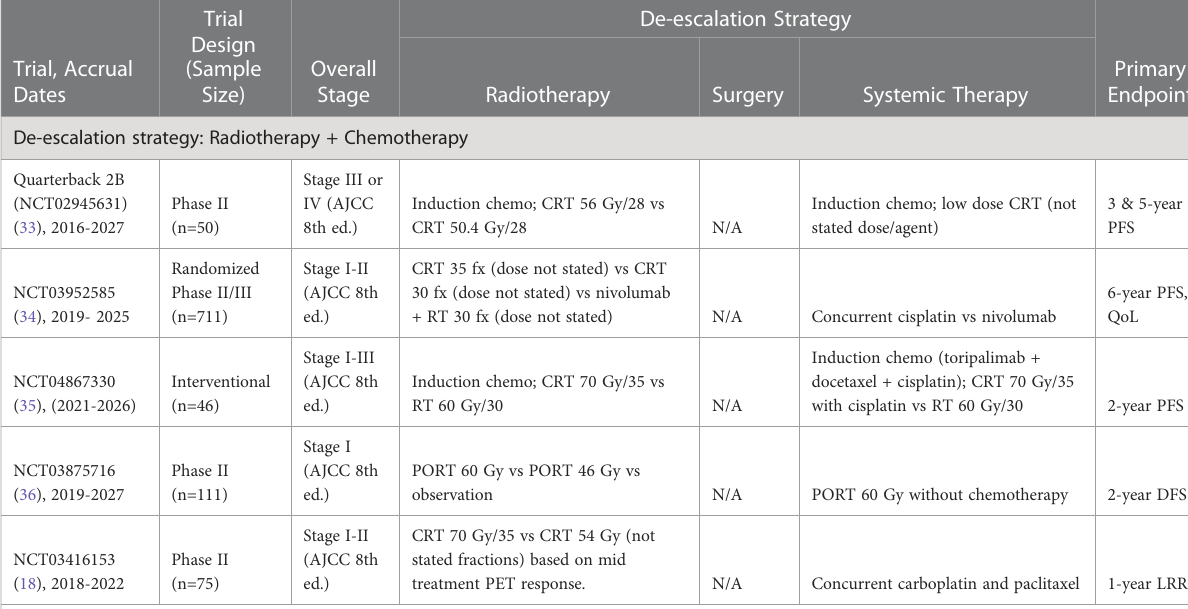
TABLE 4 Current trials examining radiotherapy and chemotherapy de-escalation for treatment of HPV-associated OPSCC.